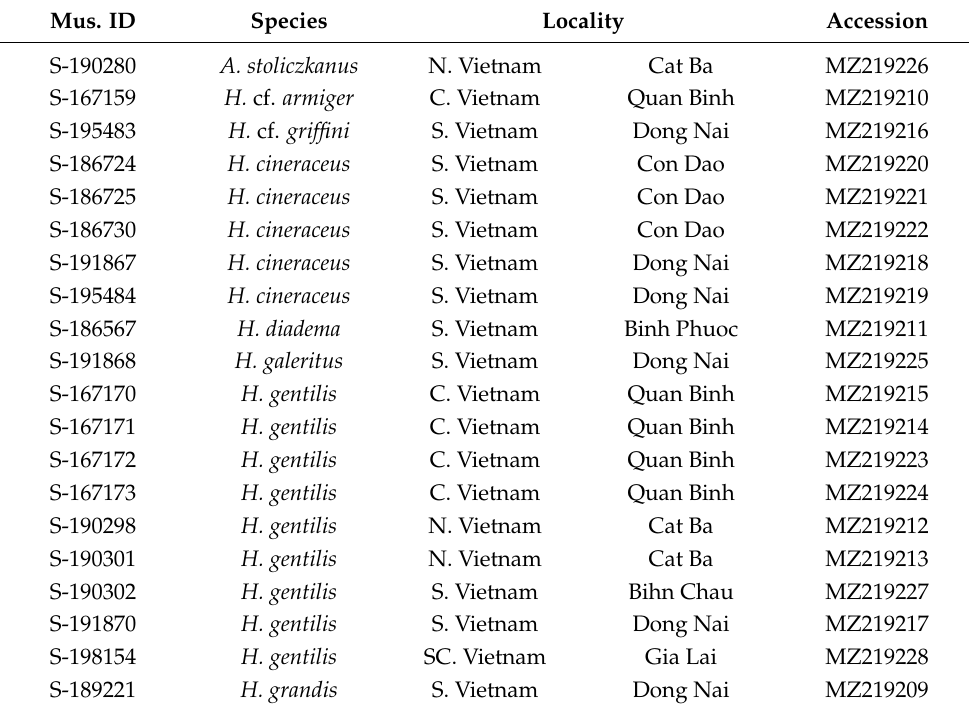
Table 1. List of specimens from ZMMU used in the cytb analysis. Mus.